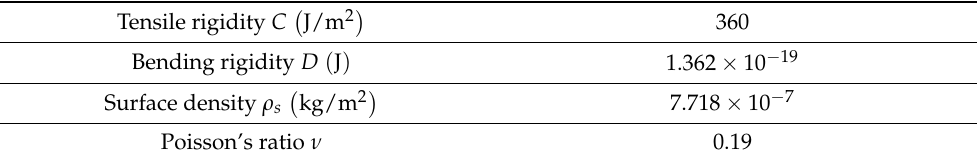
Table 2. Mechanical parameters adopted in the isotropic elastic shell